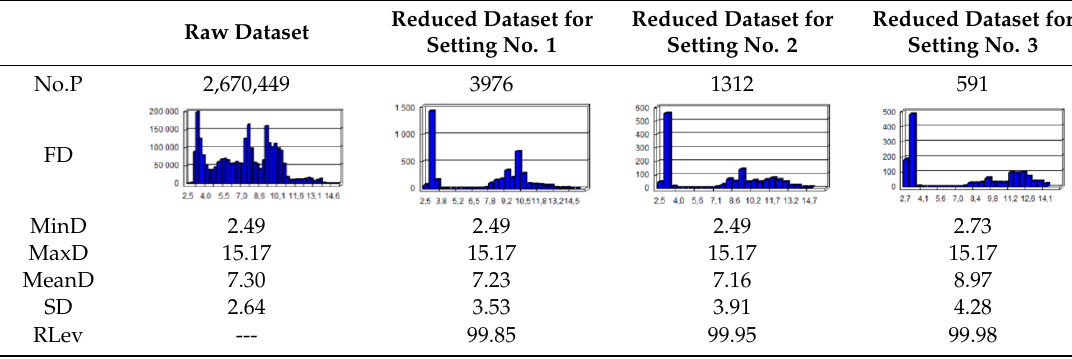
Figure 6. The points based on the LNG port area: ( a ) raw data; ( b ) dataset reduced with the Optimum Dataset (OptD) method for setting no. 1; ( c ) dataset reduced with the OptD method for setting no. 2; ( d ) dataset reduced with the OptD method for setting no. 3.